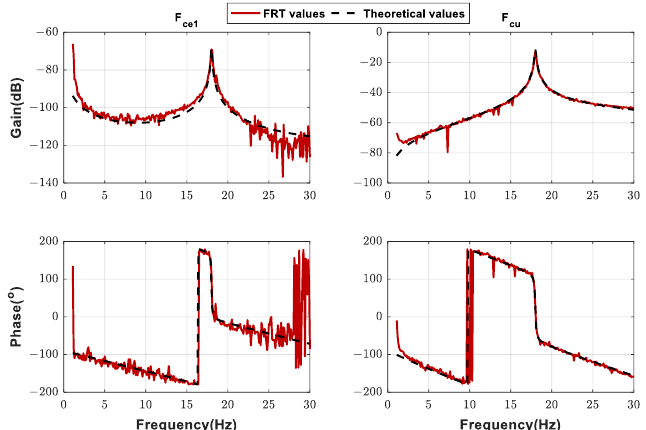
Figure 23. Comparison of FRFs between FRT values and theoretical values: F ce and F cu .